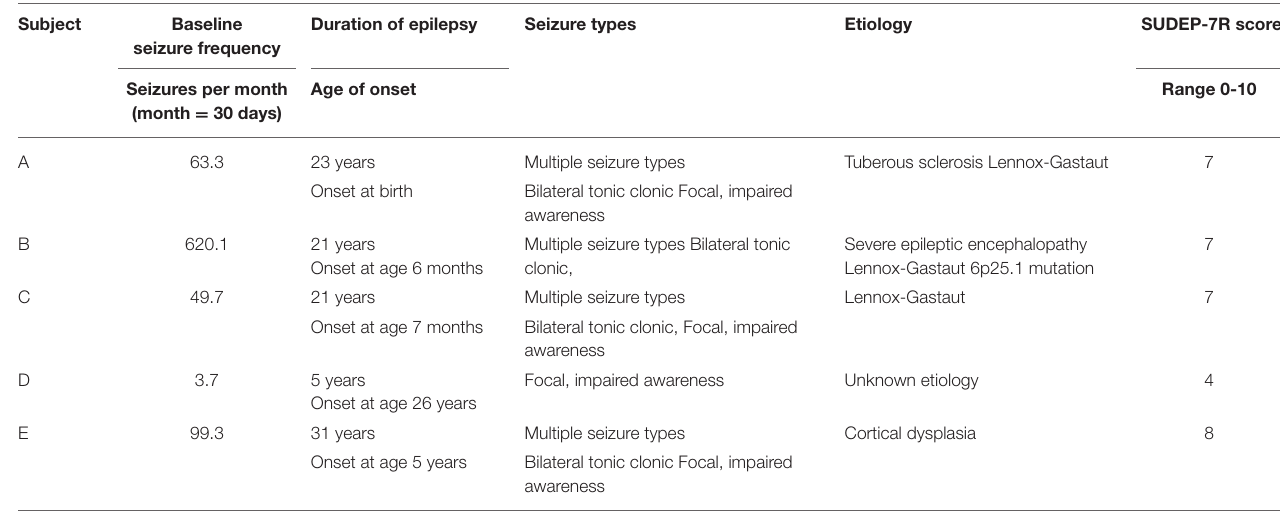
TABLE 1 | Summary of Subject